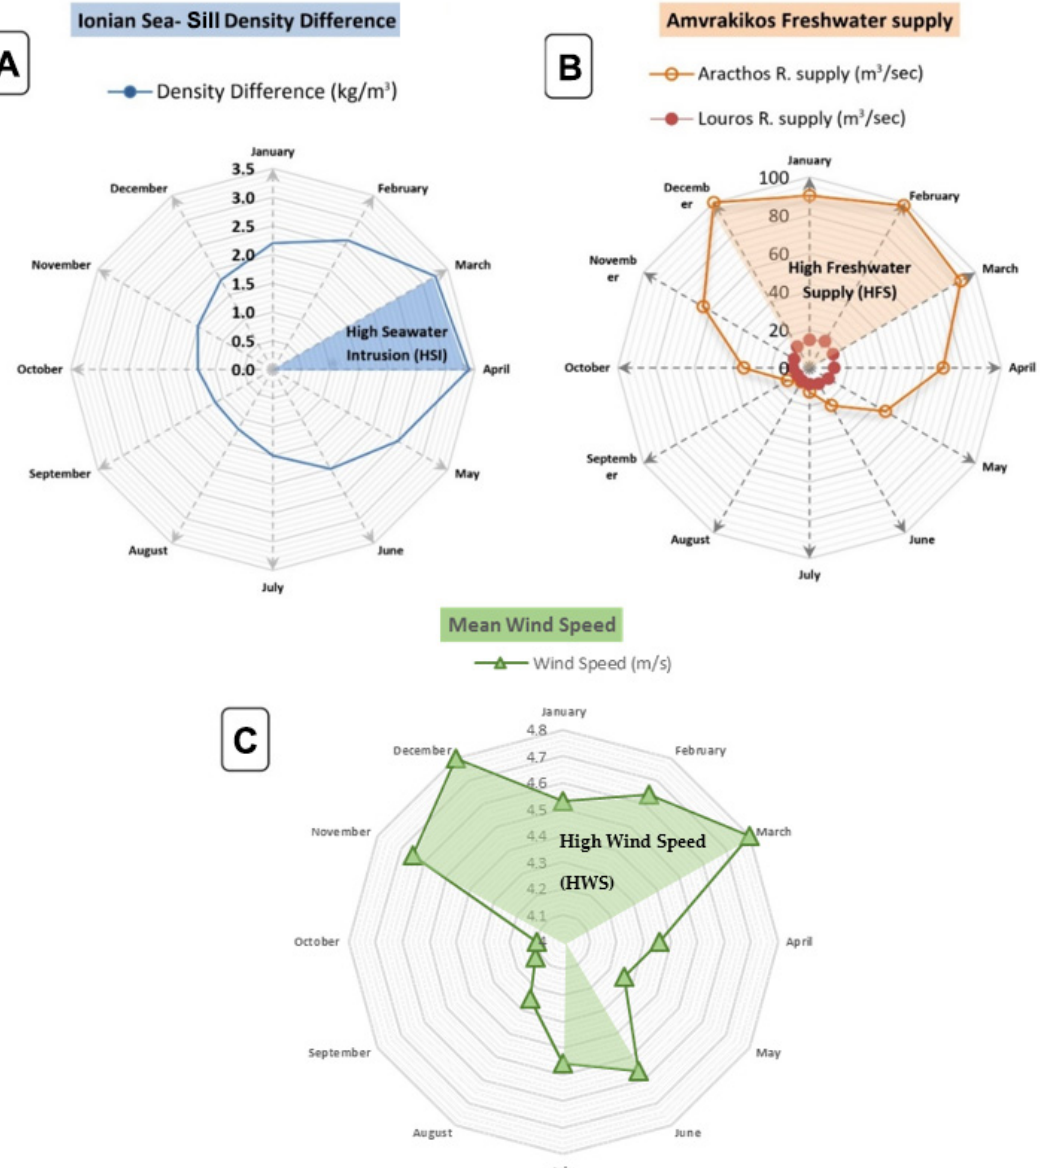
Figure 5. ( A ) Density difference (kg/m 3 ) per month between the Ionian Sea and the sill, HSI: high seawater intrusion; ( B ) freshwater supply per month in m 3 /s from Aracthos (light orange) and Louros (orange) rivers, HFS: high freshwater supply (data acquired by Hellenic Public Power Corporation—HPPC, DEI); and ( C ) monthly mean wind speed (m/s) chart of Amvrakikos Gulf (Hellenic National Meteorological